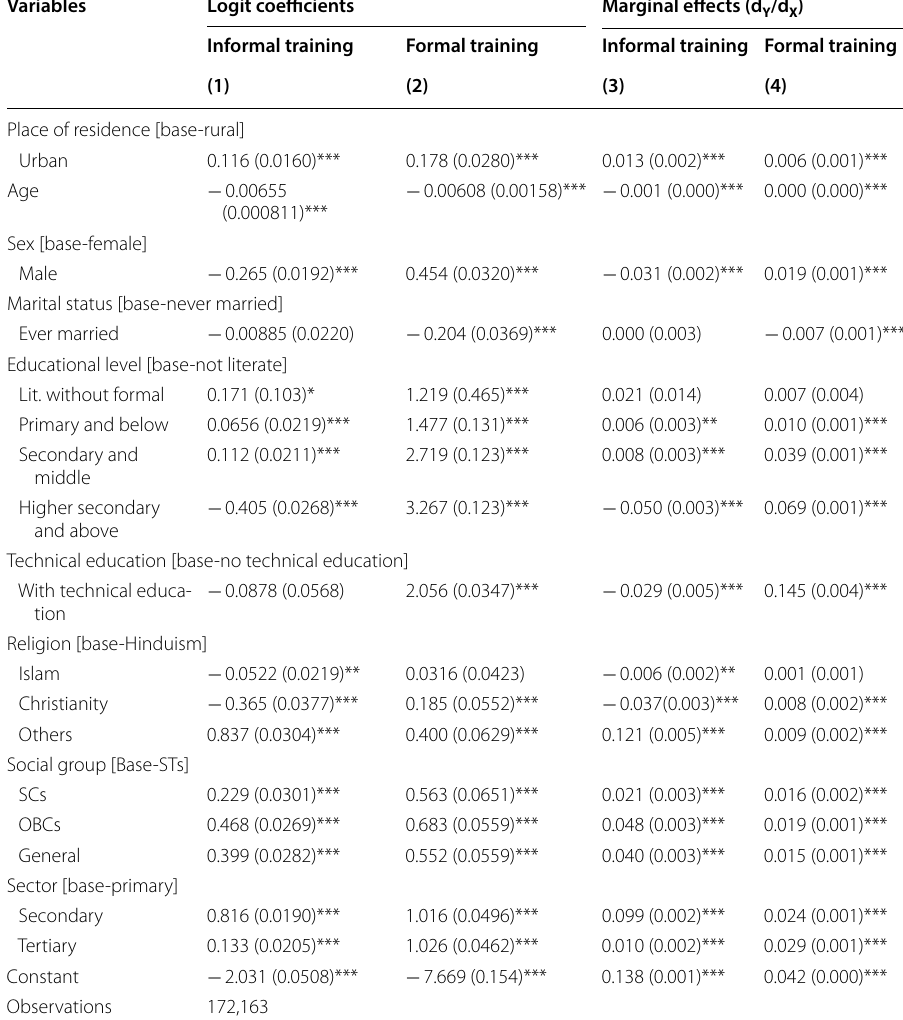
Table 7 Determinants of formal and informal training (Multinomial Logit